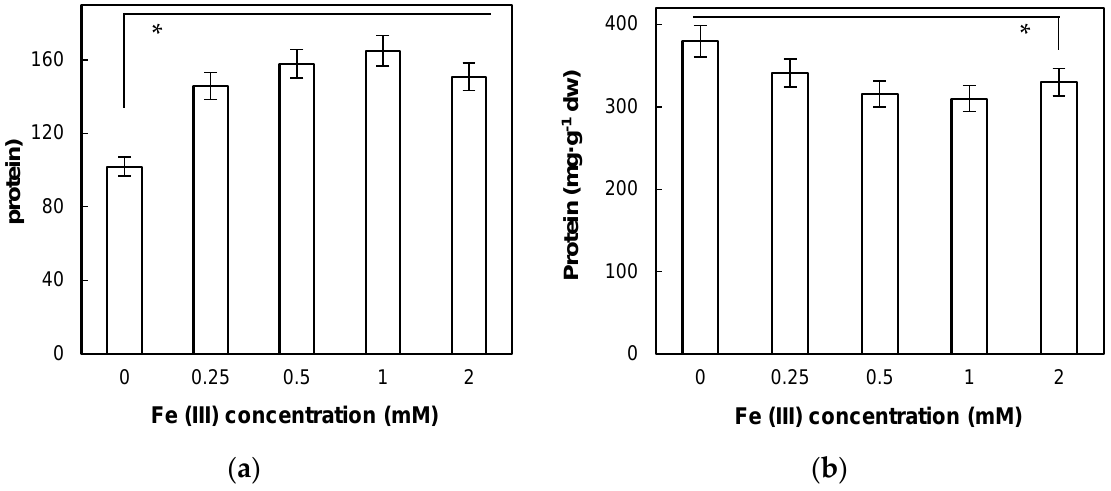
Figure 4. Effect of Fe (III) on the SOD enzyme activity ( a ) and total cell protein content ( b ) of C. onubensis cultures. The data presented correspond to day 11 of cultures incubation in Fe (III), last day of experiment. (*) Represents the significant differences of all treatments with respect to the control with 95% confidence.